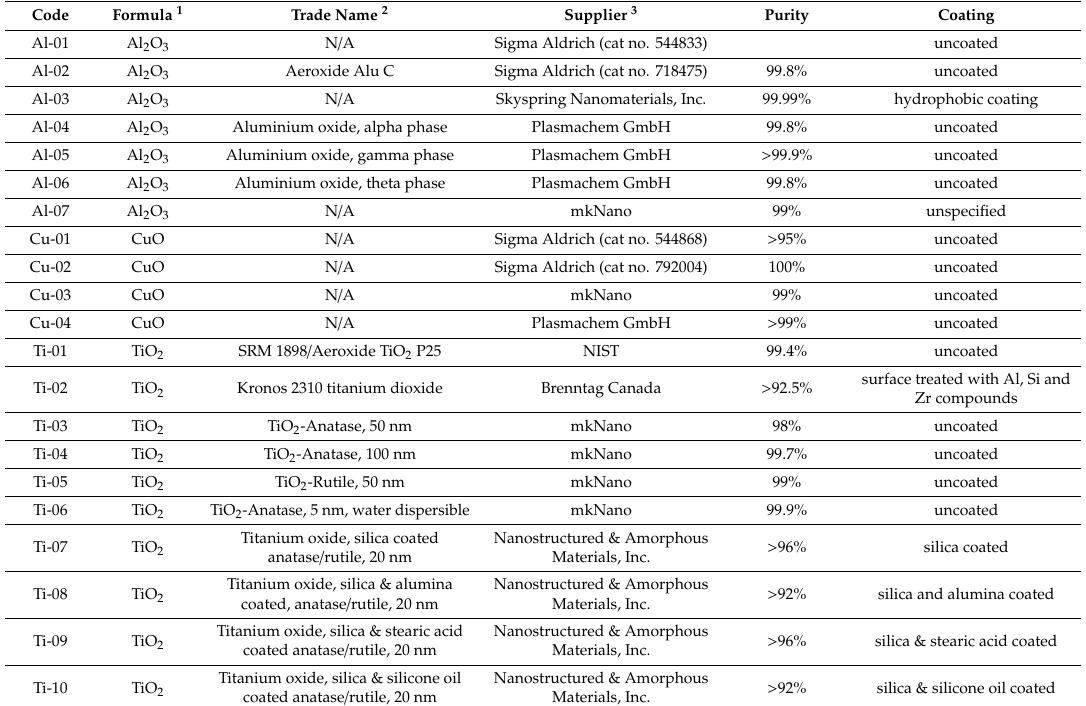
Table 1. List of the metal oxides studied, their supplier, reported purity and